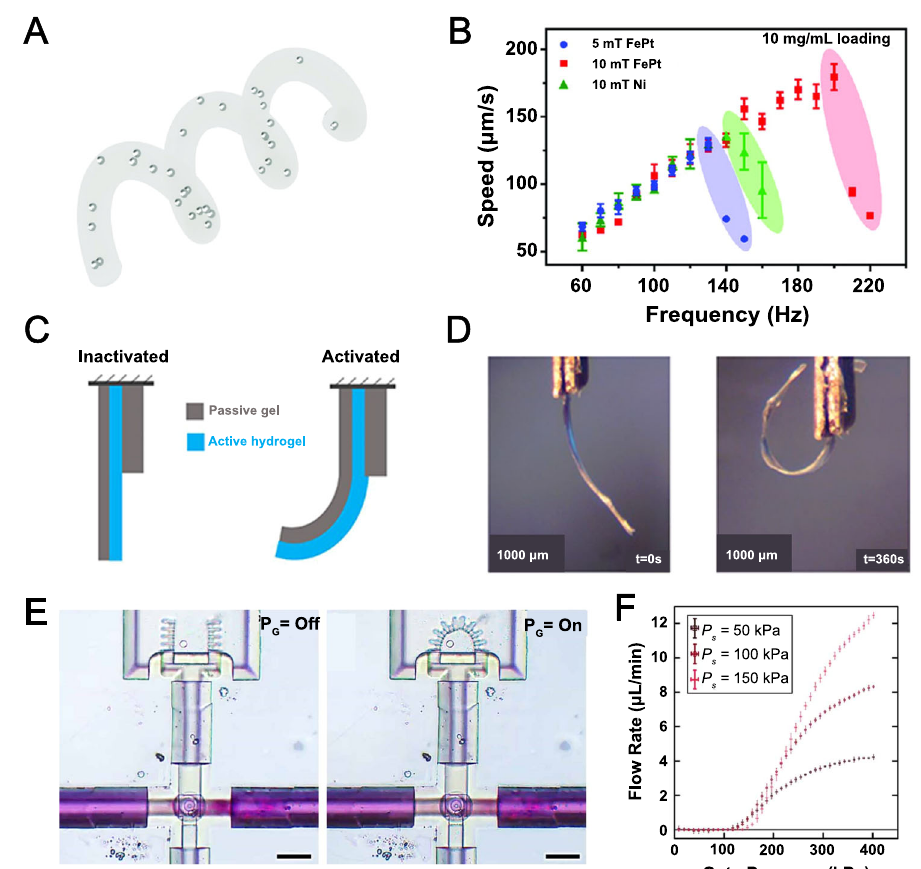
Fig. 5 | Microrobots and microactuators. A , B Two-photon-polymerization (TPP) three-dimensional (3D) printed iron platinum nanoparticle-based magnetic helical microswimmers. A Conceptual design of a trimethylolpropane ethoxylate triacry- late (PETA) magnetic helix with three turns and embedded FePt or super- paramagnetic iron-oxide nanoparticles (SPIONs). B Swimming velocity of 30 μ m long SPION/PETA and FePt/PETA magnetic helical microswimmers. FePt-based microswimmers were able to endure higher frequencies (with higher step-out